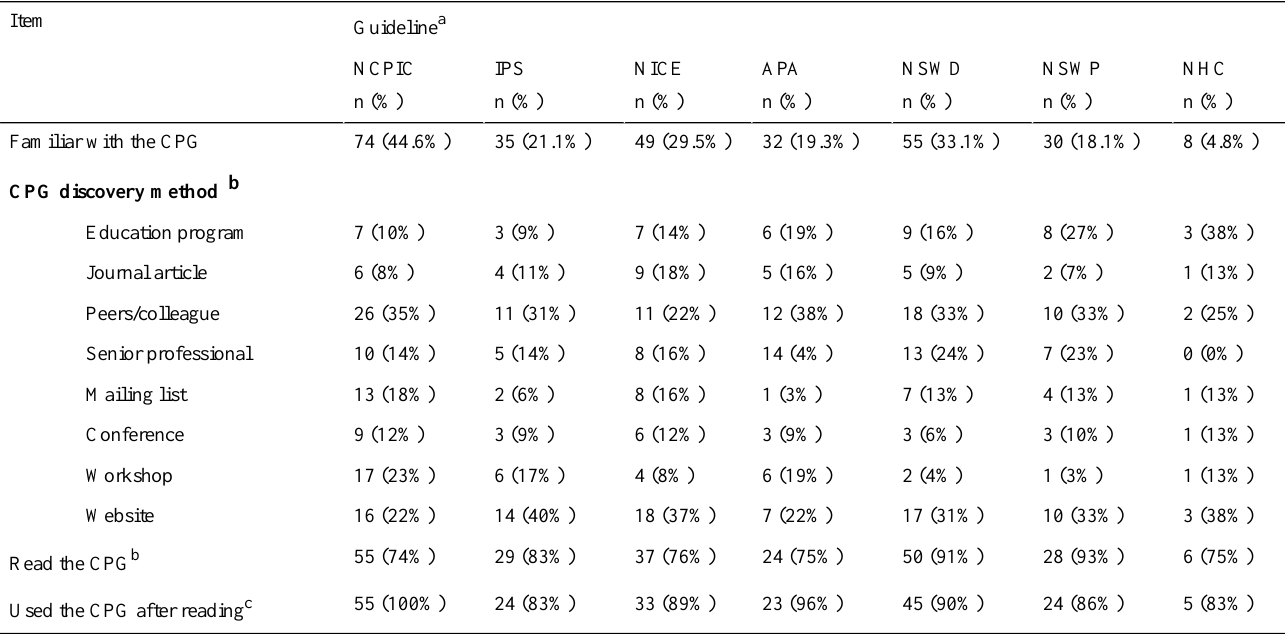
Table 4. Familiarity with clinical practice guidelines (CPGs).